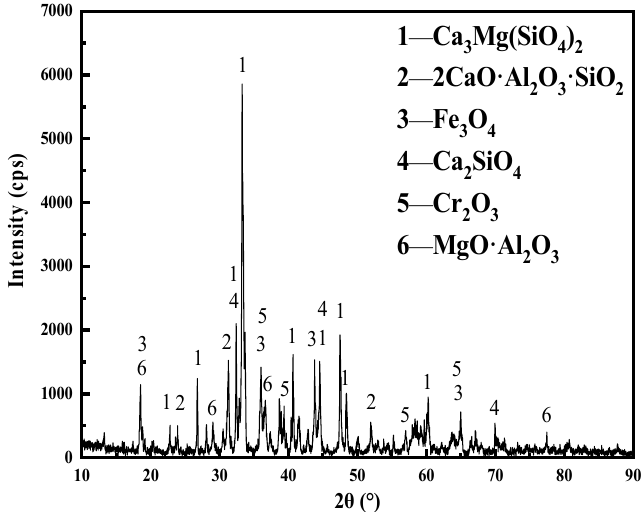
Figure 2. XRD pattern of the original EAF slag.